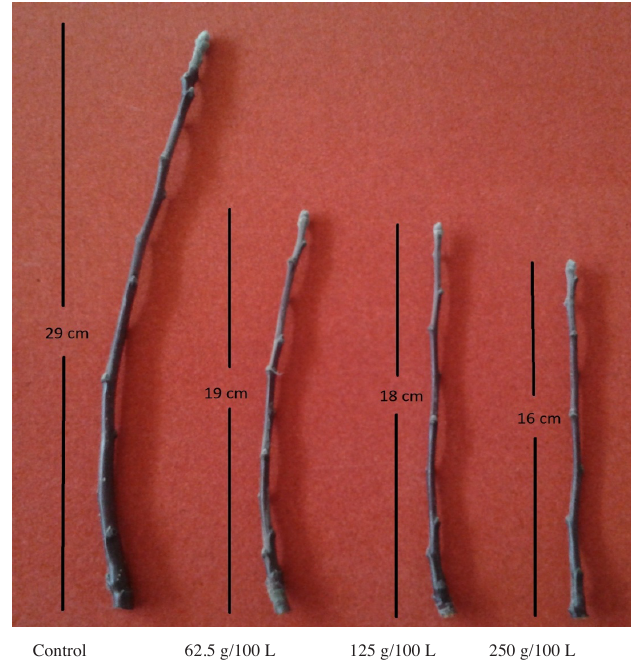
Fig. 3: The effect of Pro-Ca on average shoot